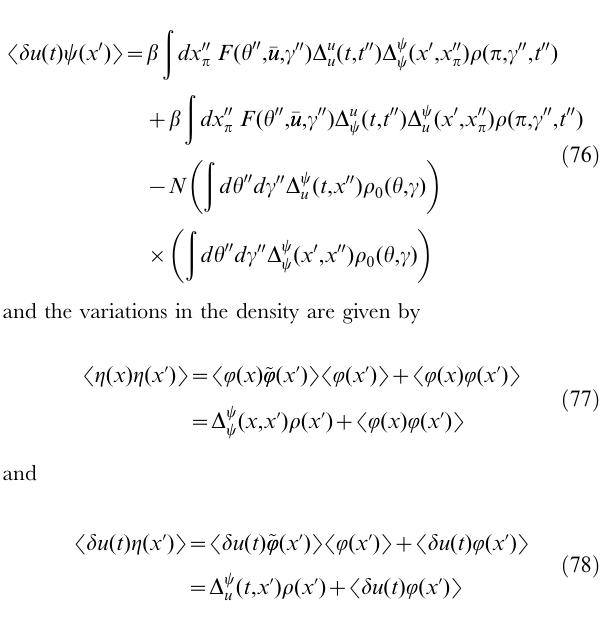
Graphs are constructed by connecting the vertices shown in Figure 4 using the four edges defined by the linear response.